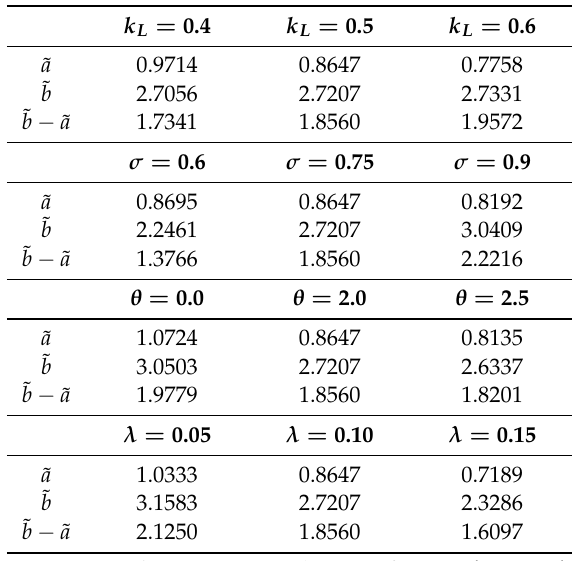
Table 2. Effects of k L , θ , σ , and λ on [ ˜ a , ˜ b ]